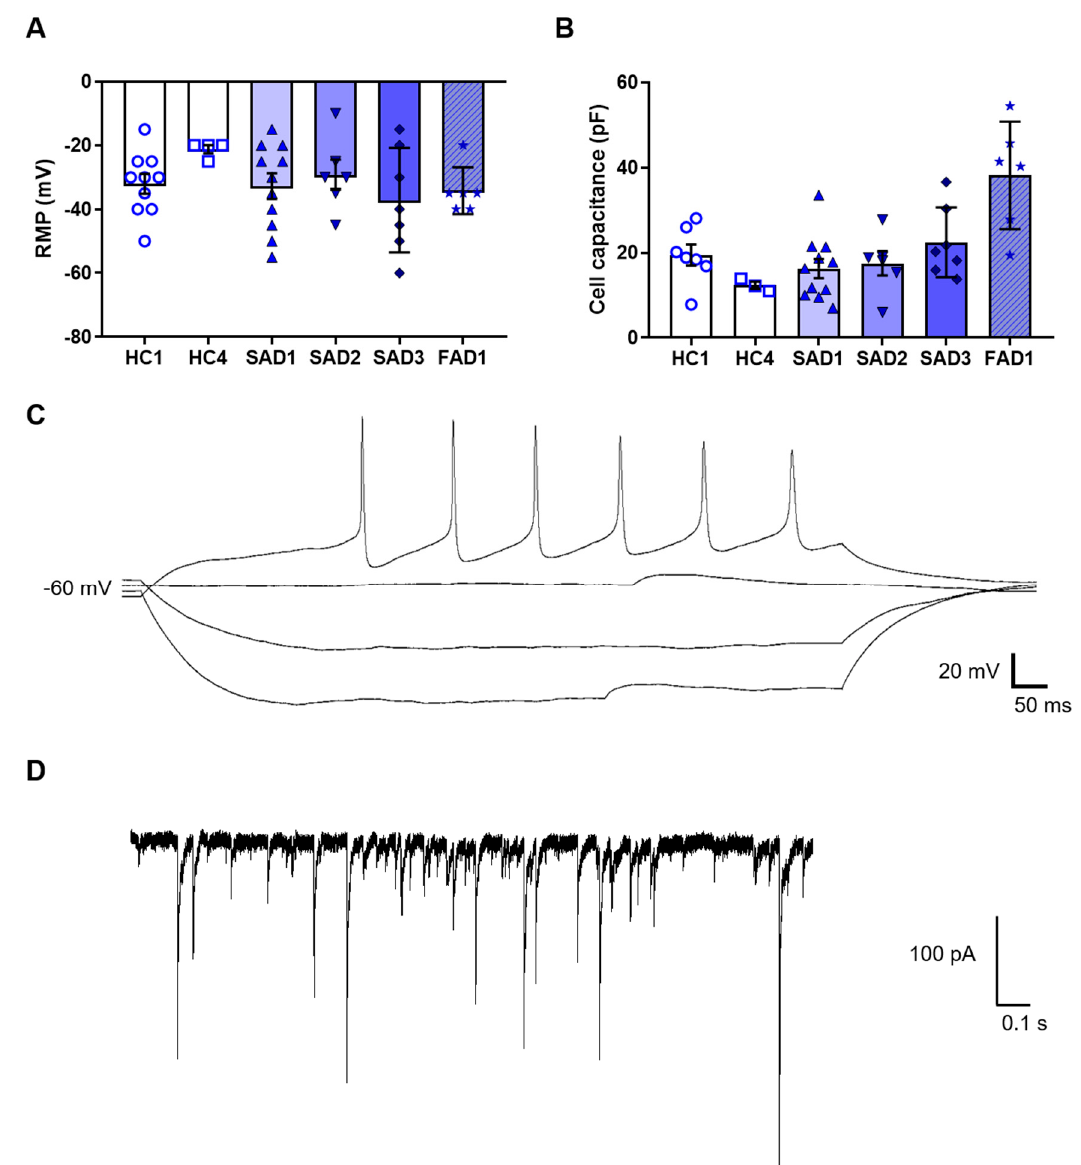
Figure 6. Electrophysiology data of BFCN cultures at week 4 of maturation. ( A ) Resting membrane potential and ( B ) cell capacitance. ( C ) Sample trace of a train of action potentials when membrane potential was held at − 60 mV. ( D ) Sample trace of synaptic events. Data in A and B were derived from 6 BFCN differentiated samples. Individual data points representing individual cells are shown. Histogram bars represent mean values and error bars represent S.E.M.